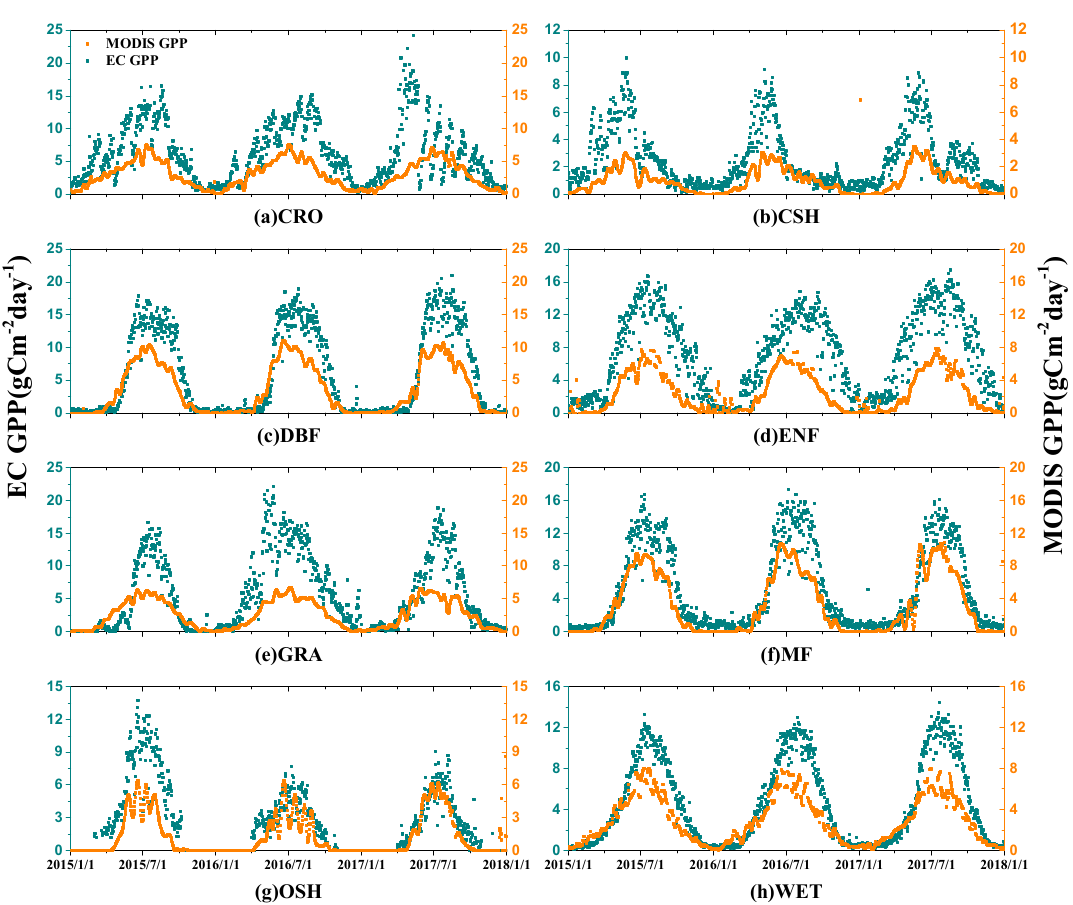
Figure 5. The seasonal trends of tower GPP and MODIS GPP (MYD17A2H) from January 1, 2015 to January 1, 2017, for di ff erent vegetation types: ( a ) CRO, ( b ) CSH, ( c ) DBF, ( d ) ENF, ( e ) GRA, ( f ) MF, ( g ) OSH, and ( h ) WET. Cyan square indicates flux tower GPP and the orange square indicates MODIS GPP data.